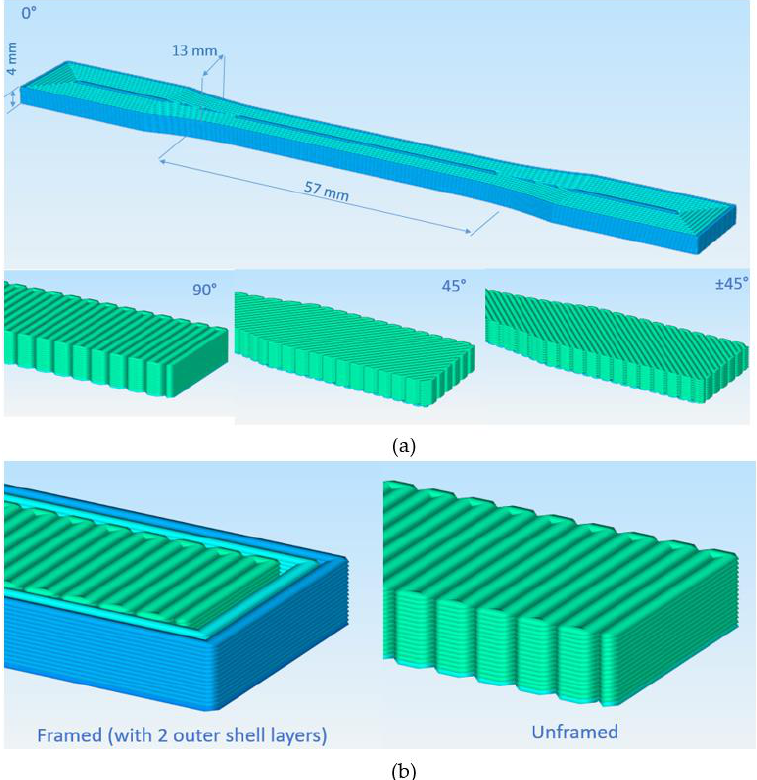
Figure 1. ASTM D638 tensile test specimens ( a ) according to infill raster angles and ( b ) frame configuration.